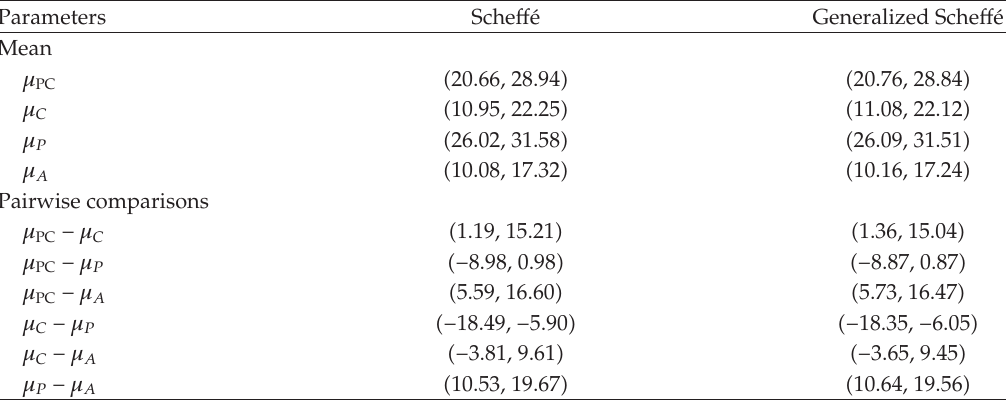
Table 3: The simultaneous Sche ff ´e intervals and Generalized Sche ff ´e’s intervals on means and pairwise mean di ff erences in the cigarette example.